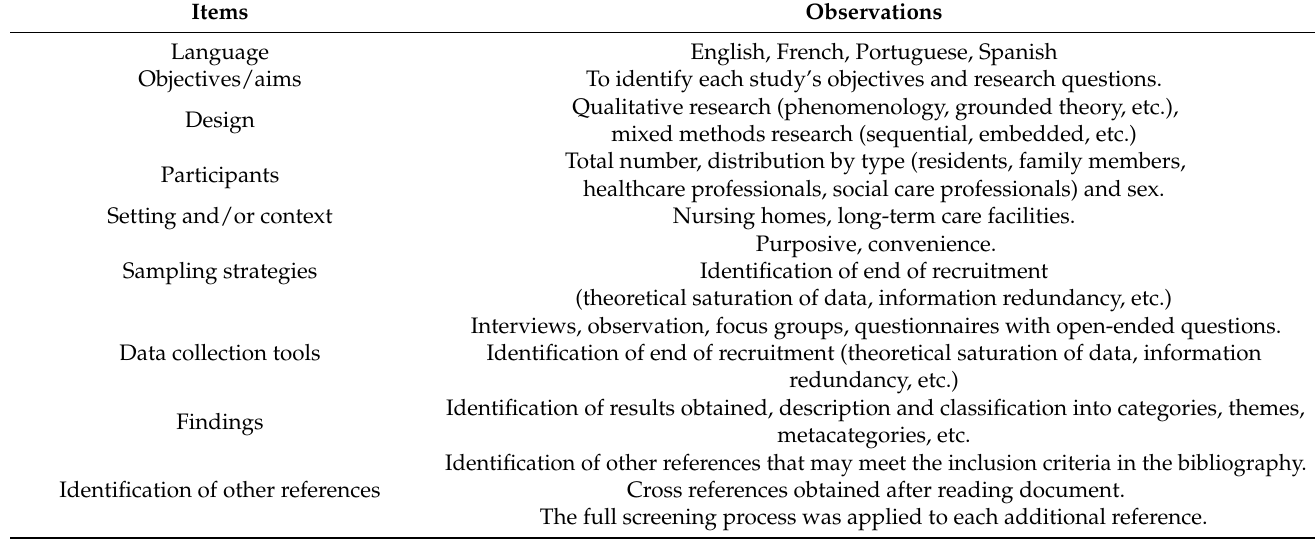
Table 2. Variables included in the fourth search phase.